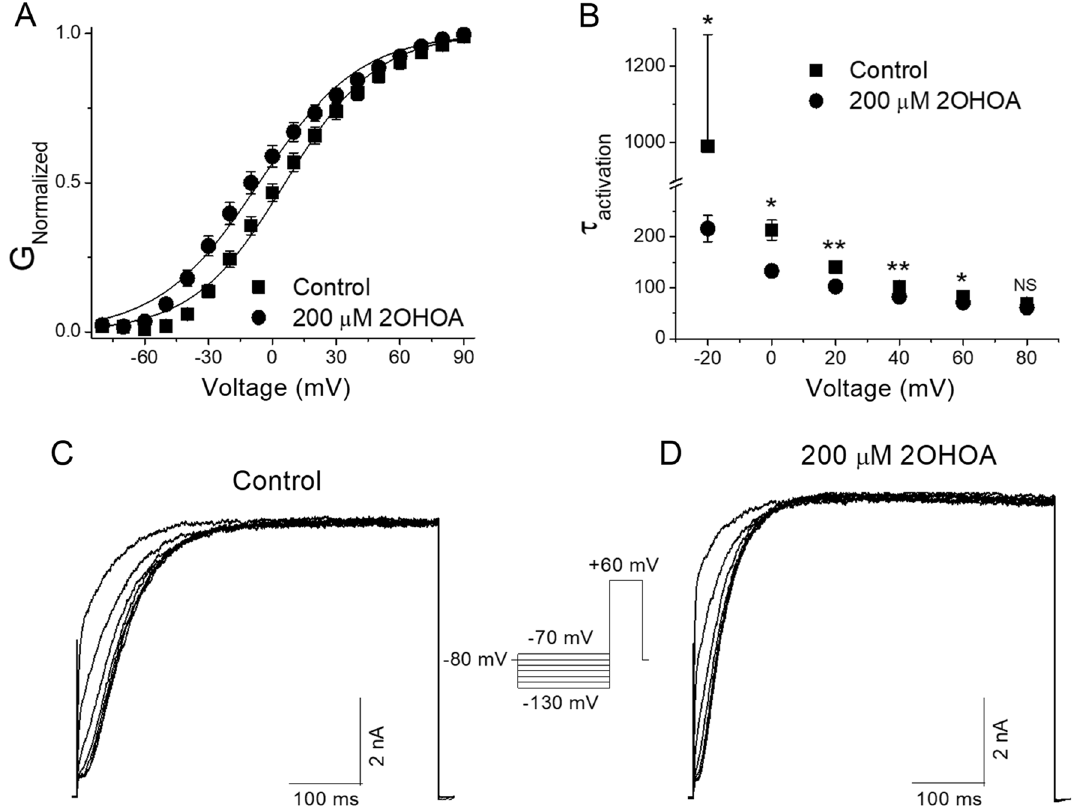
Fig. 2 Effect of 2OHOA on the voltage‑dependence of activation, activation kinetics and Cole‑More shift of Kv10.1 channel. A conductance‑voltage ( G – V ) curves before (squares) and after application of 200 µM 2OHOA (circles). The V 1/2 values were 5.9 recorded before and after 2OHOA, respectively (n and after 2OHOA application (circles; n ( C ) and 200 µM 2OHOA treated cells ( D ). similar results were obtained in five more cells. Data are represented as mean